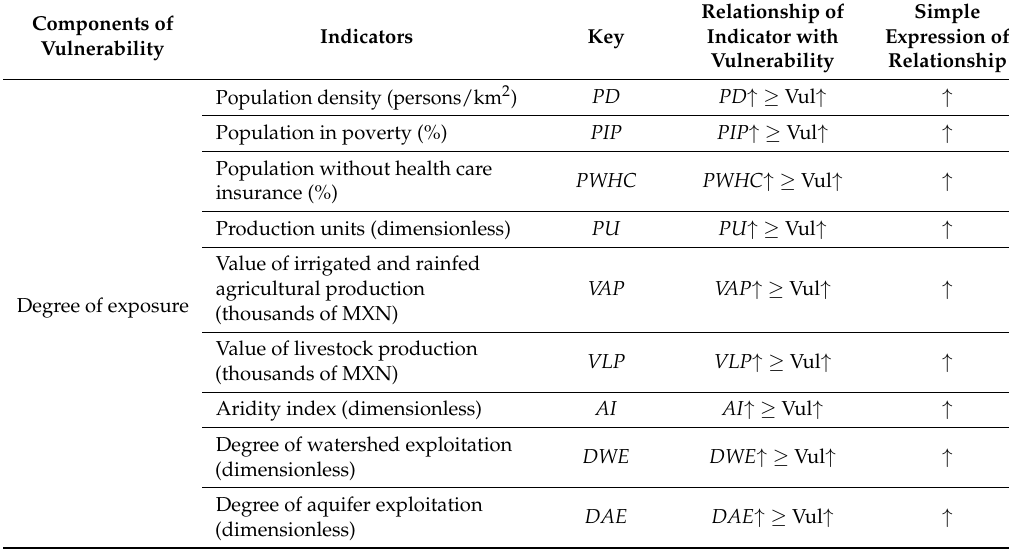
Table 6. Selected indicators and their functional relationship with vulnerability to